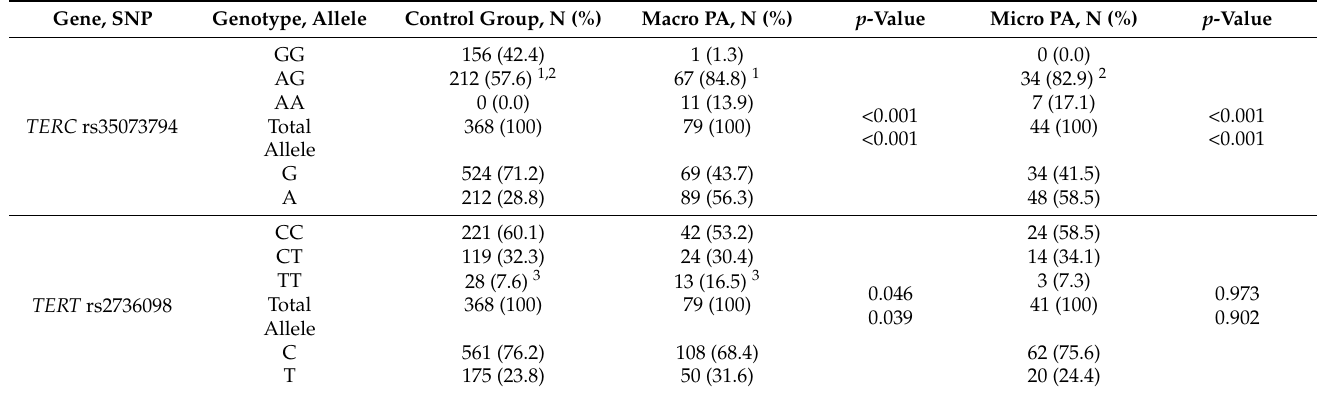
Table 10. TERC , and TERT genes single nucleotide polymorphisms frequencies of genotypes and alleles within macro or micro pituitary adenoma and control groups.